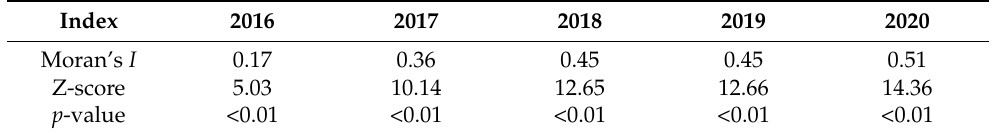
Table 2. Spatial autocorrelation test